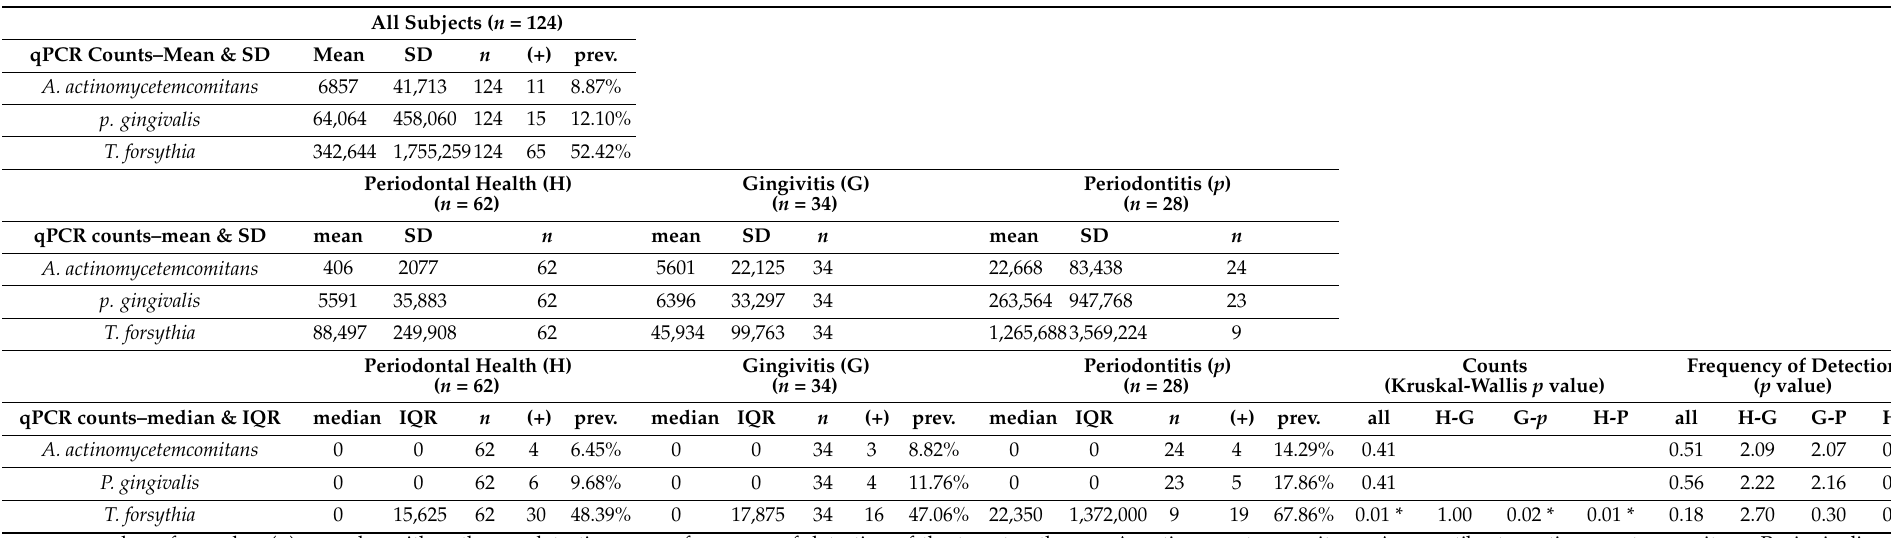
Table 3. Microbiological findings (quantitative polymerase chain reaction, qPCR), with PCR counts expressed as means and standard deviations (SD) or as medians and interquartile ranks (IQR) and frequencies of detection as percentages, for the complete study population and for each study group, with the appropriate comparisons. All Subjects ( n =